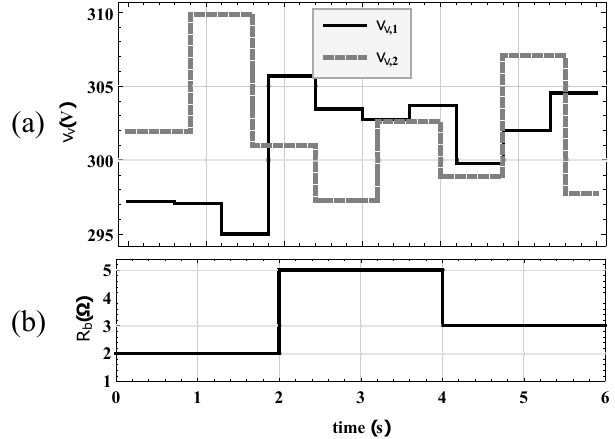
Figure 13. ESS energy capacity requirement against ESS cut-off frequency.